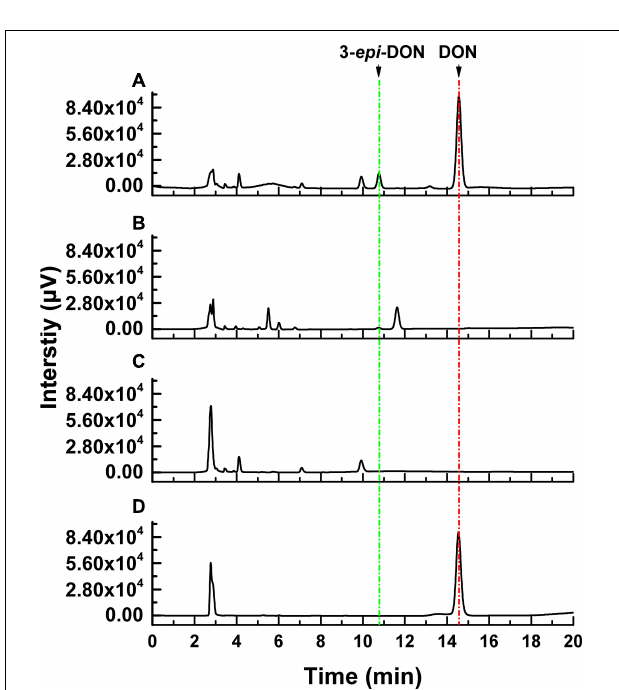
FIGURE 3 | High-performance liquid chromatography analysis of DON degradation products after incubation of DON with (A) filtered intracellular supernatant treated, (B) intracellular supernatant, and (C) untreated Nocardioides sp. ZHH-013 cells. (D) The 168.74 µ M DON standard was used as control.